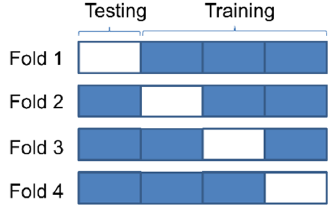
Figure 8. Four-fold cross-validation. Figure 8. Four ‐ fold cross ‐ validation.